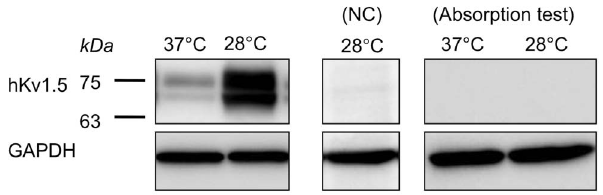
Figure 2. Low temperature exposure increases the protein expression levels of hKv1.5. Western blot analysis of the total membrane proteins extracted from the CHO-hKv1.5s cells (left panel) or native CHO cells (NC, as a negative control) cultured at 37 u C or 28 u C for 48 h. The specificity of the hKv1.5 antibody was characterized by an antigen absorption test. GADPH was used as control for protein loading.